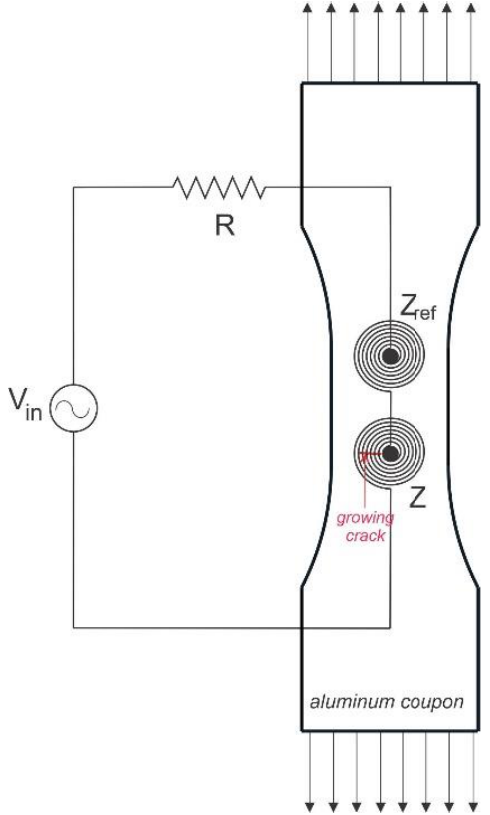
Figure 8. Schematic showing the measuring circuit with the coils attached to the coupon under tensile loading.